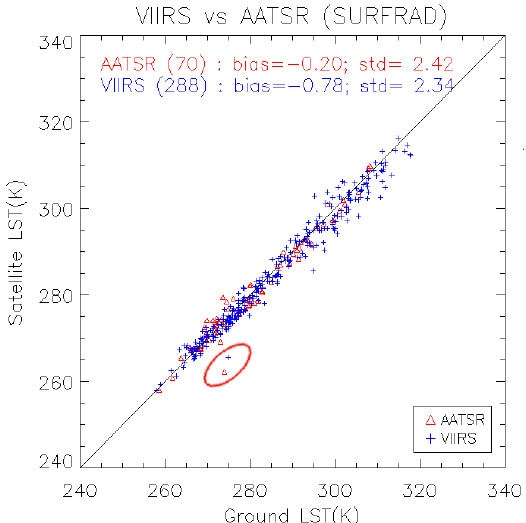
Figure 3. Scatter plots of the VIIRS LSTs (blue) and the AATSR LSTs (red) against the SURFRAD LSTs compared in the period from 1 February 2012 to 8 April 2012. Overall accuracy and precision of the satellite LSTs referring the SURFRAD LSTs are noted. Some VIIRS LST plots are circled as suspicious cloud contaminated